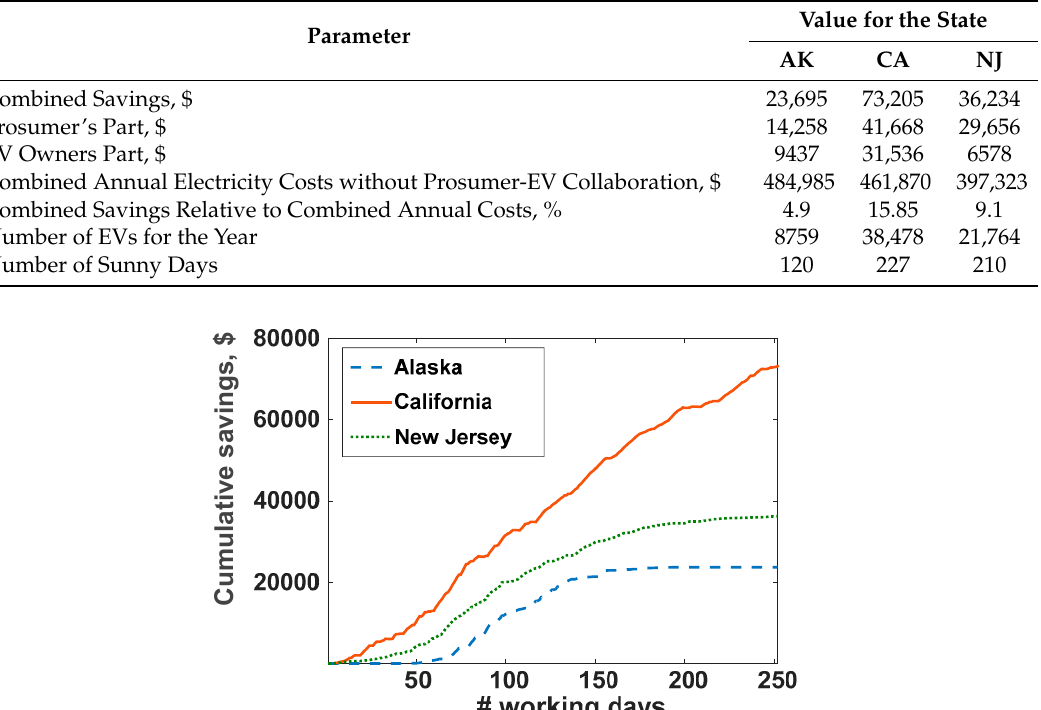
Figure 6. The savings are significant in all states despite large variation in solar radiation and retail electricity price. Table 2. A summary of results.